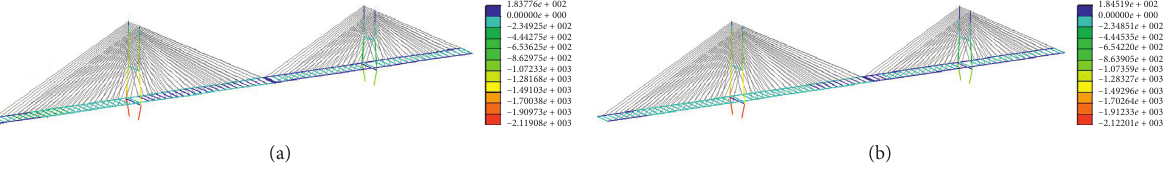
Figure 21: Stress distributions on pylons and the main girder for the repair cases (unit: tonf/m 2 ): (a) repair scheme 1 and (b) repair scheme 2.